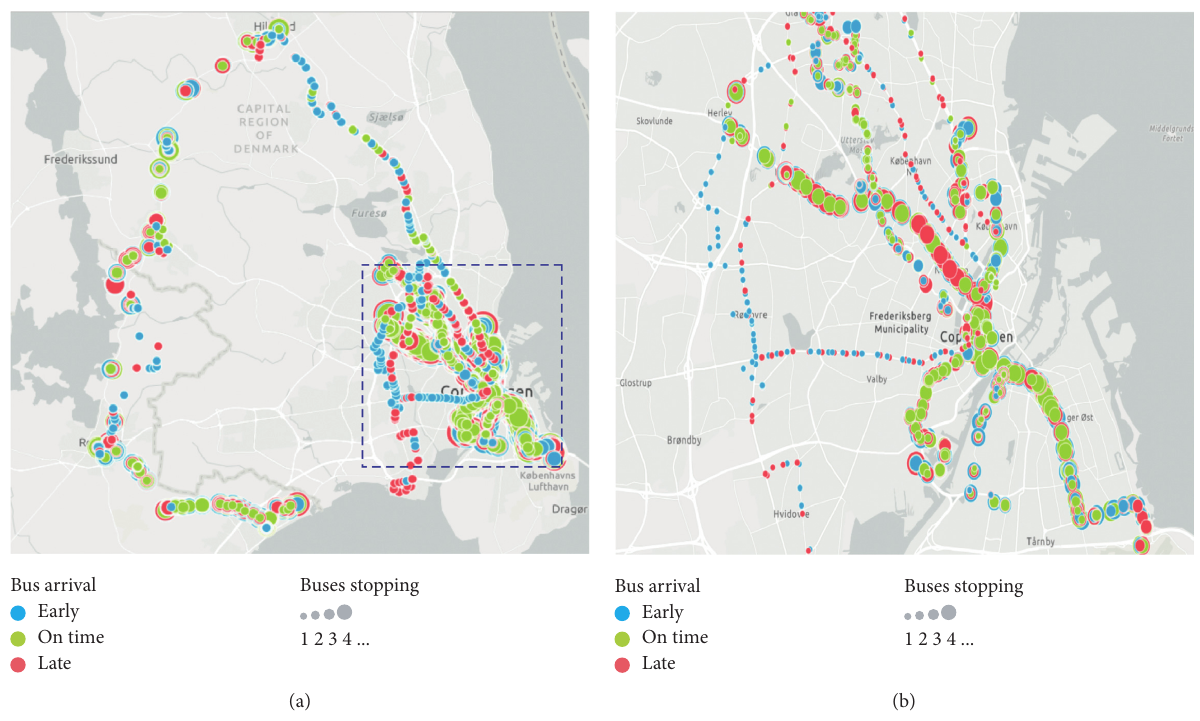
Figure 3: Real-time visualisation of route statuses, where the colour indicates the type of delay being reported; (a) status at all bus stops of the city of Copenhagen,;(b) status at bus stops around the city centre.